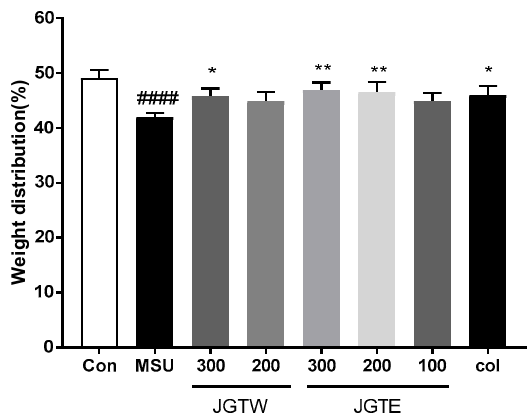
Figure 4. Effect of JGTW and JGTE on hind paw weight-bearing distribution in mice with MSU crystal-induced gouty arthritis. The weight-bearing distribution ratio was measured using a dynamic weight-bearing (DWB) device, compared to that of the MSU crystal-injected group. Con, control mice; MSU, MSU crystal-injected mice; JGTW, MSU-injected mice treated with JGTW; JGTE, MSU-injected mice treated with JGTE; Col, MSU-injected mice treated with 1 mg/kg of colchicine. Data are presented as the mean ± SEM ( n = 5). #### p < 0.0001 vs. Control group and * p < 0.05, ** p < 0.01 vs. MSU group.